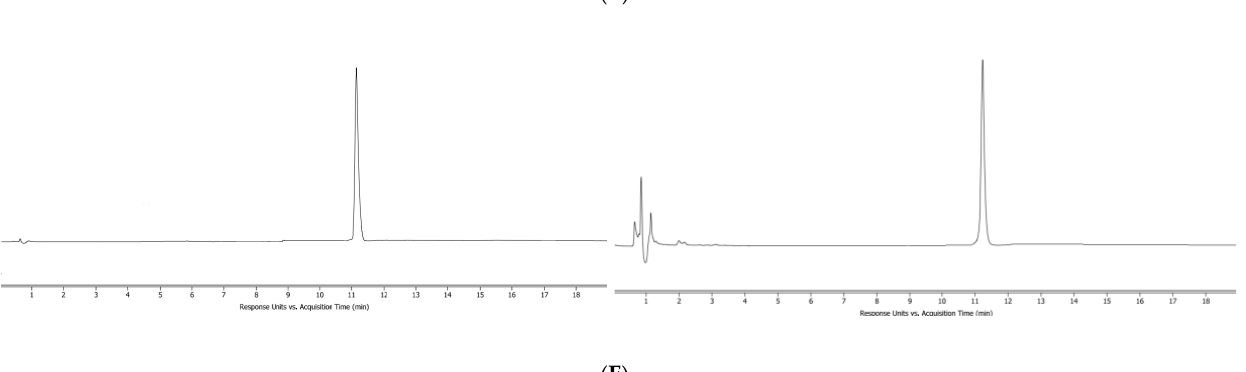
Figure 2. UPLC chromatogram of reference solution ( I ) and sample solution ( II ); ( A ) brucine; ( B ) strychnine; ( C ) liquiritin; ( D ) isoliquiritin; ( E ) isoliquiritigenin; ( F ) glycyrrhizic